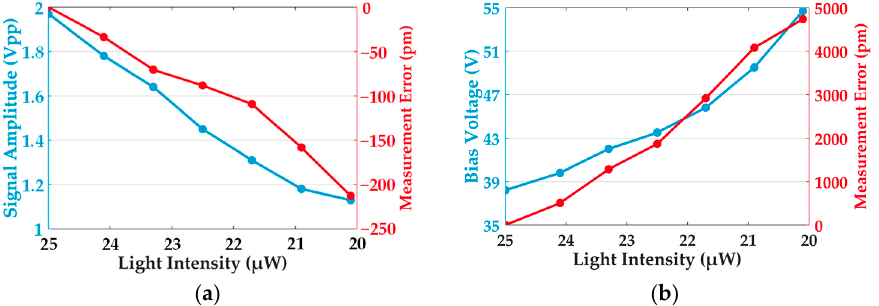
Figure 7. Results of signal amplitude and bias voltage using ( a ) best-gain detection method and ( b ) auto-gain detection method. ( b ) auto-gain detection